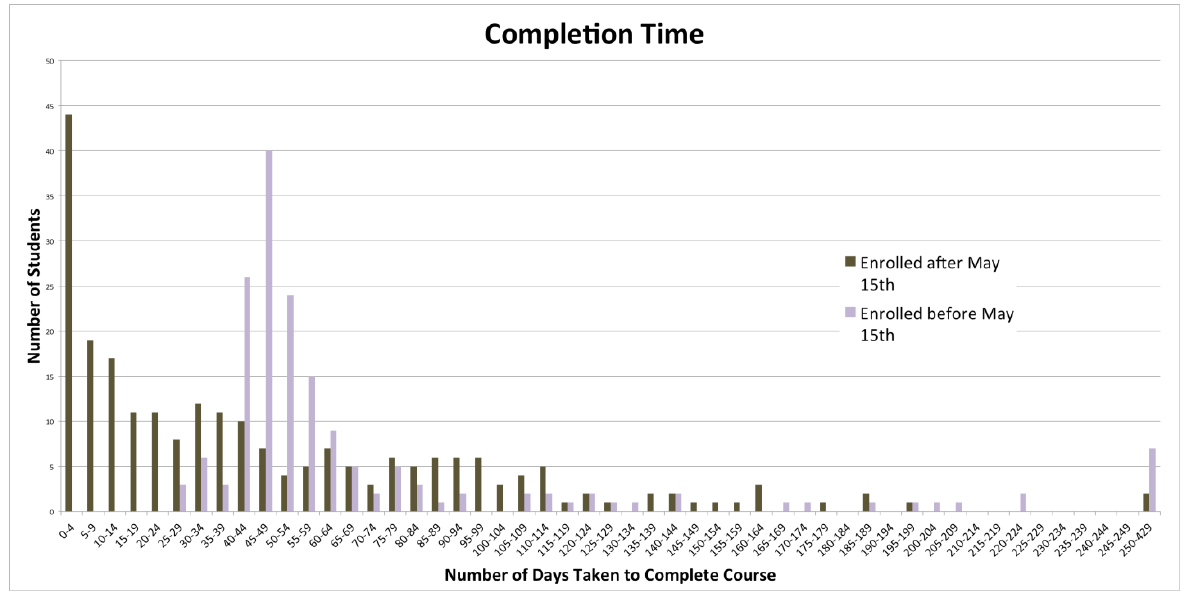
Figure 6. Number of days taken by students to complete the course content. Students in the first cohort (active phase) took around 7 weeks to complete the course, similar to the length of the active phase. Students in the second cohort (passive phase) finished much more quickly, with the largest group completing the material in less than five days.